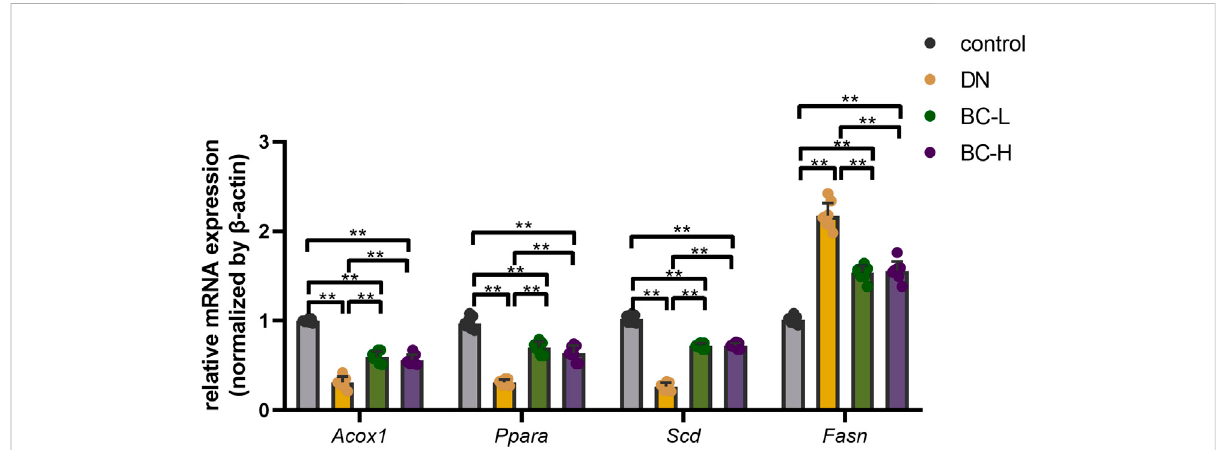
FIGURE 8 Real-time PCR analysis for main DEGs (differentially expressed genes) expression. Bailing Capsule increased the mRNA levels of Acox1 (acyl- CoA oxidase 1), Ppara (peroxisome proliferator activated receptor α ), Scd (stearoyl-CoA desaturase) and inhibited the mRNA levels of Fasn (fatty acid synthase) in DN (diabetic nephropathy) rats. DN, diabetic nephropathy; BC-L, low dosage of Bailing Capsule; BC-H, high dosage of Bailing Capsule. Data are expressed as mean ± SD ( n = 8). ** p <